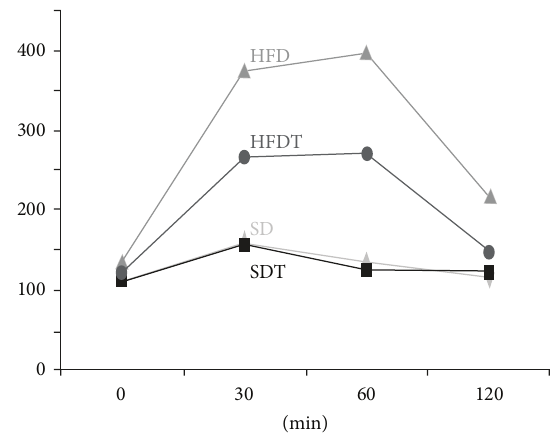
Table 2: Mean body weight in grams with standard